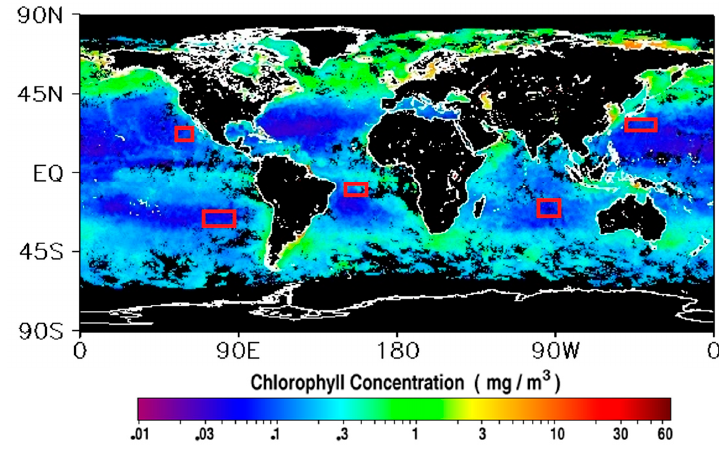
Figure 3. 2015 September–October global chlorophyll concentration (red squares show the target distribution for the Rayleigh scattering calibration, Unit: mg/m 3 ).